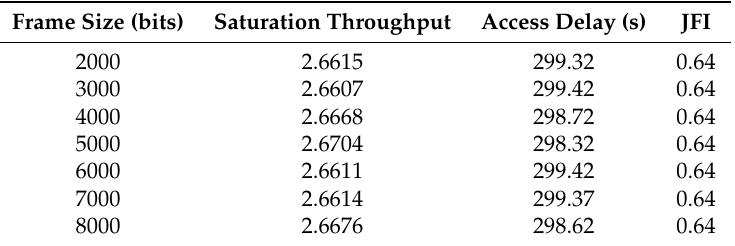
Table 5. Performance of SA-MMAC at different packet payload